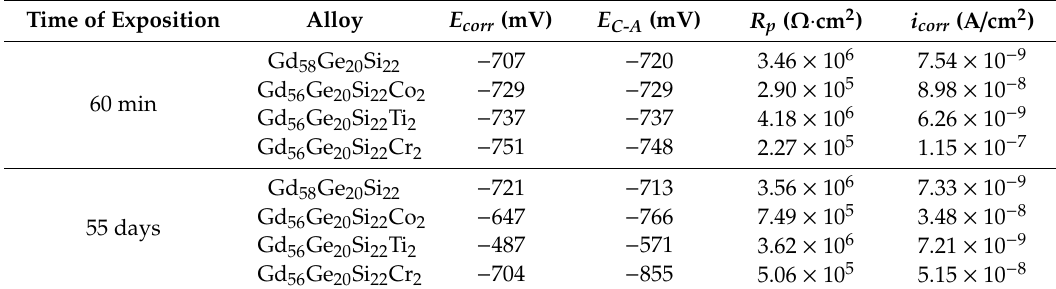
Table 1. Corrosion potential ( E corr ), cathodic to anodic transition potential ( E C – A ), polarization resistance ( R p ) and corrosion current density ( i corr ) for the Gd 58 Ge 20 Si 22 , Gd 56 Ge 20 Si 22 Co 2 , Gd 56 Ge 20 Si 22 Ti 2 and Gd 56 Ge 20 Si 22 Cr 2 alloys in 3% NaCl solutions after two exposure times.